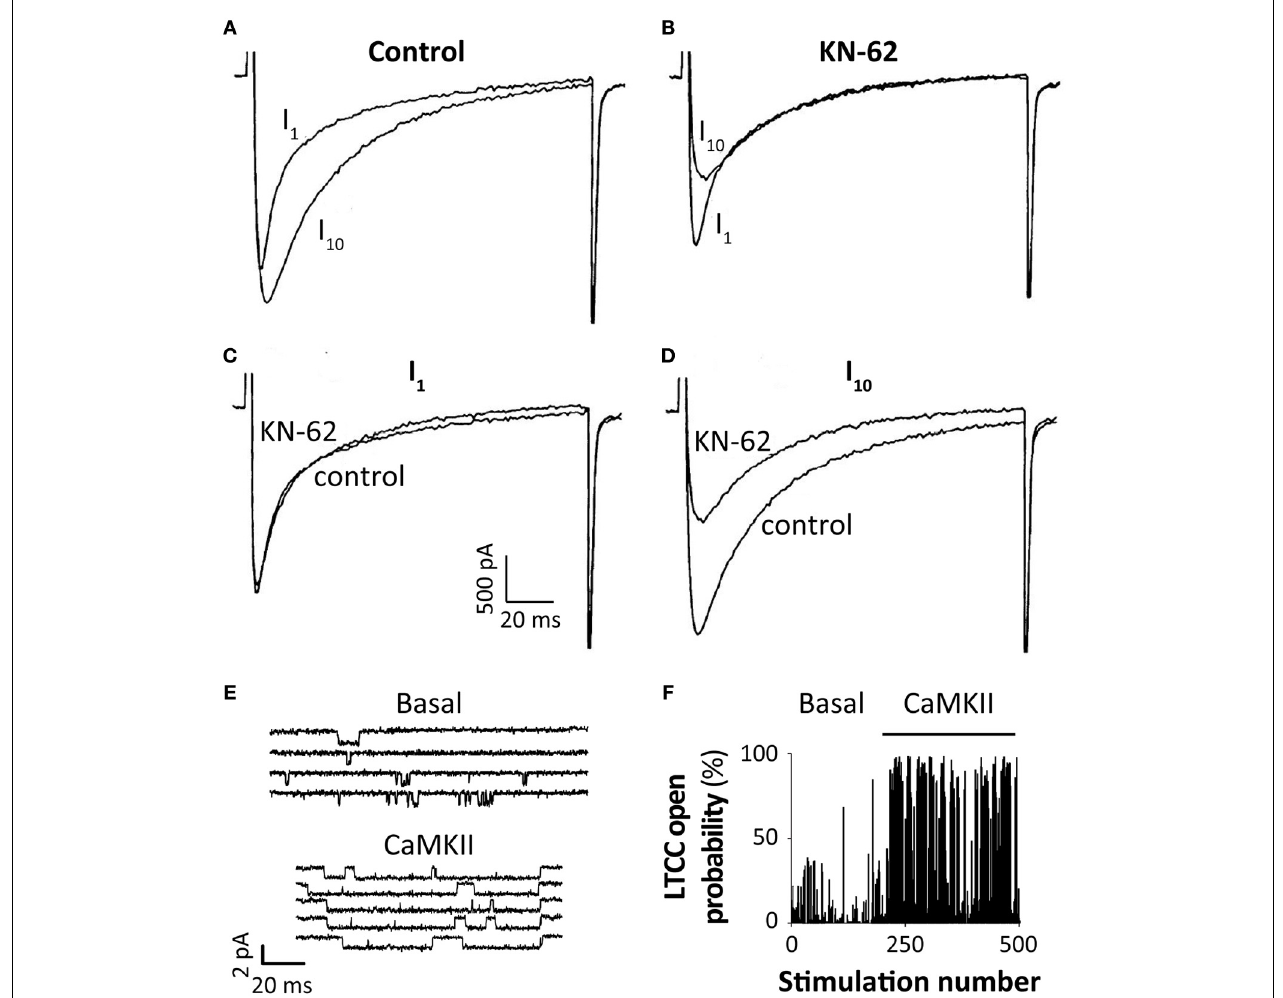
FIGURE 4 | CaMKII-dependent regulation of I Ca . Superimposed I Ca traces from the first (I 1 ) and tenth (I 10 ) voltage-clamp pulse from − 90 to 0mV at 2Hz in a single rabbit ventricular myocyte obtained in control condition (A) or after 10min equilibration with the CaMKII inhibitor KN-62 (1 μ M) (B) ; I 1 and I 10 obtained in the two conditions are respectively shown (superimposed) in panels (C,D) (modified from Yuan and Bers, 1994 with permission). (E) A single LTCC current (channel openings are seen as downward deflections